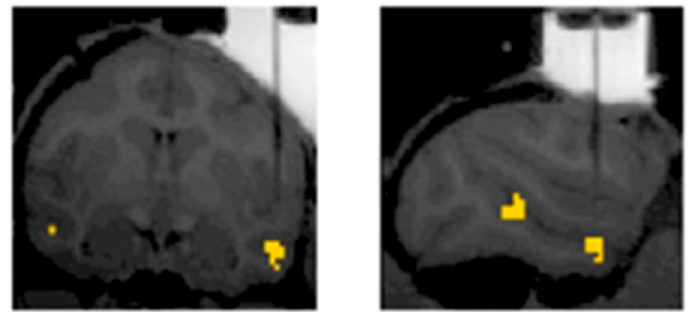
Figure 9. Electrophysiological recordings in non-human primates guided by fMRI. Adapted with permission from Kumar et al. (2019). BOLD activations in yellow indicate differences in BOLD responses evoked by the images of monkey bodies and objects. A vertical shadow indicates an electrode aimed at the ASB.